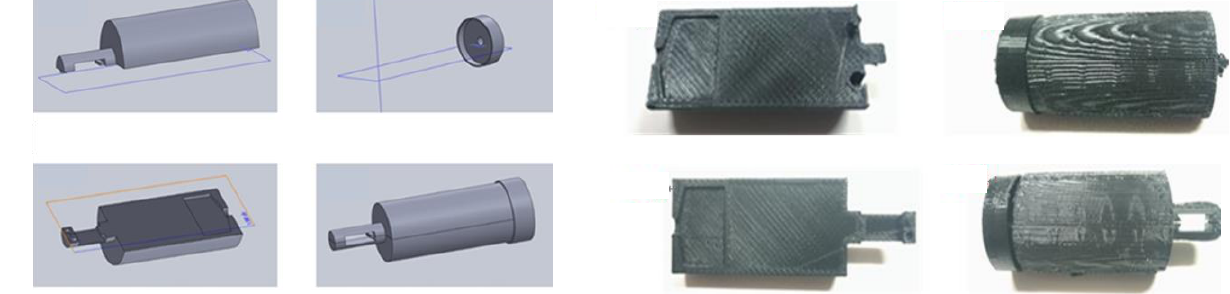
Figure 1. Image of 3D printed shell of micro-sensor.